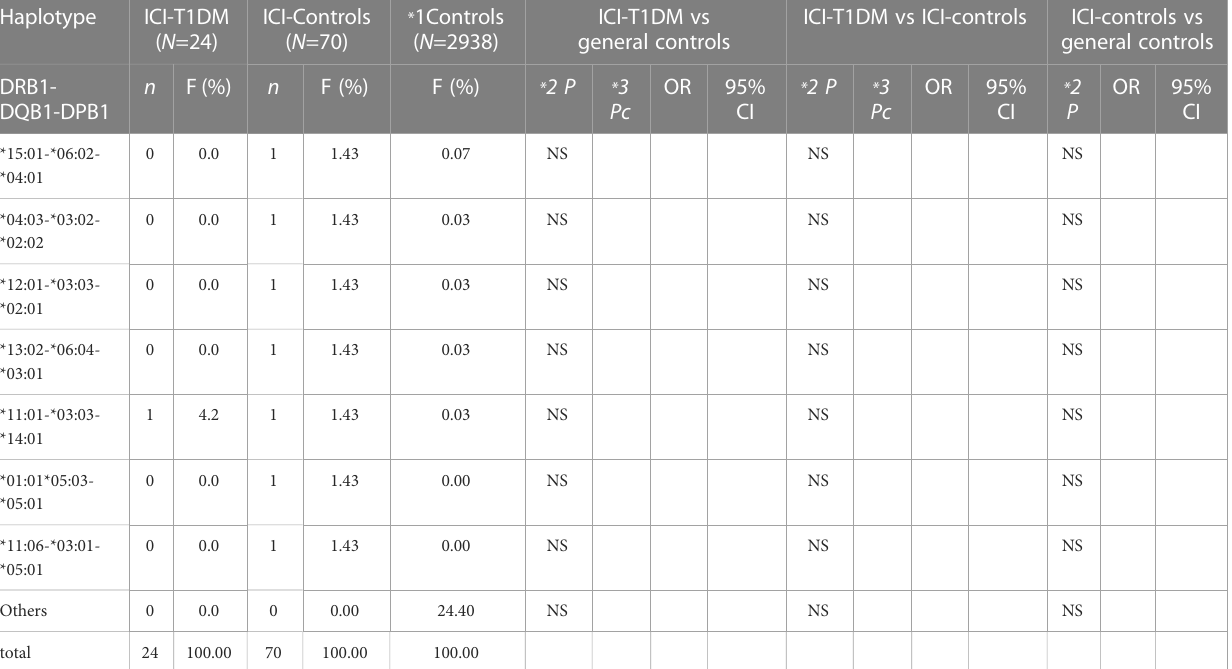
(Table 4). Besides, proinsulin epitope binding predictions to HLA- DP15 were similarly shown in Table 4. The proinsulin binding predictions to HLA-DR5 or to HLA-DP15 were different, but all portions in proinsulin including C-peptide region (AA57-87) showed binding predictions to both alleles.